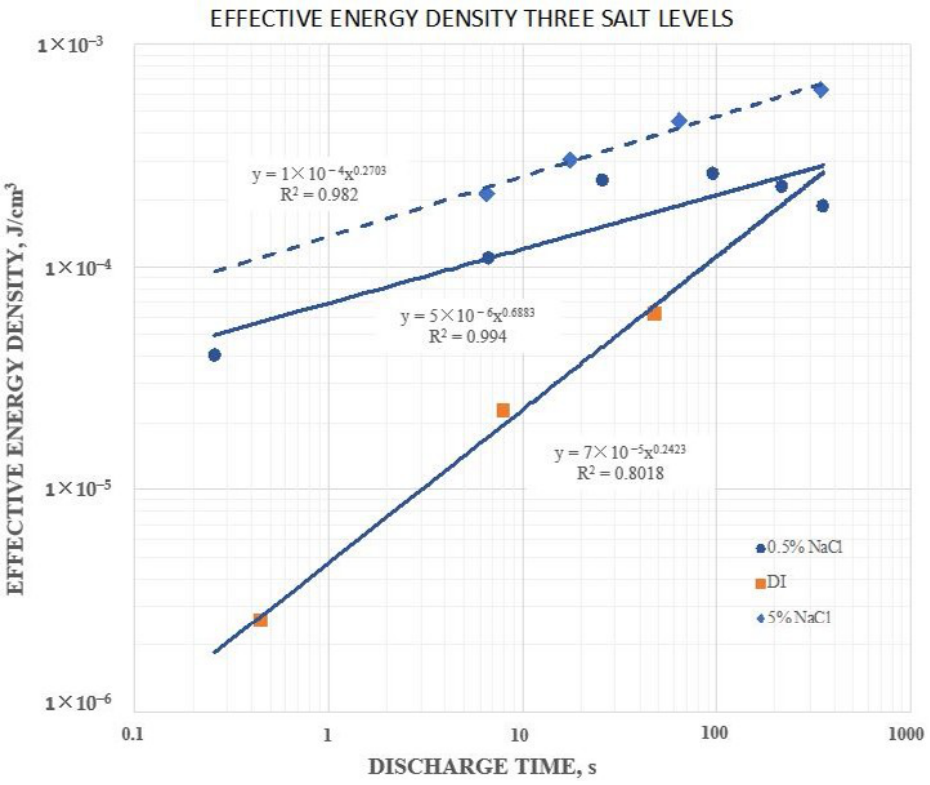
Figure 6. E ff ective energy density as a function of the salt concentration. The three curves, based on the full voltage discharge, were obtained with the 20 mm capacitor and were all for a super dielectric outside / ambient air dielectric inside configuration, all based on a program of charging to ± 10 V and holding for 200 s at ± 10 V. As the salt concentration increased, the e ff ective energy density also increased. It was clear that the e ff ective energy density for both the 0.5 and 5 wt % NaCl samples was more sensitive to discharge times than was the e ff ective dielectric